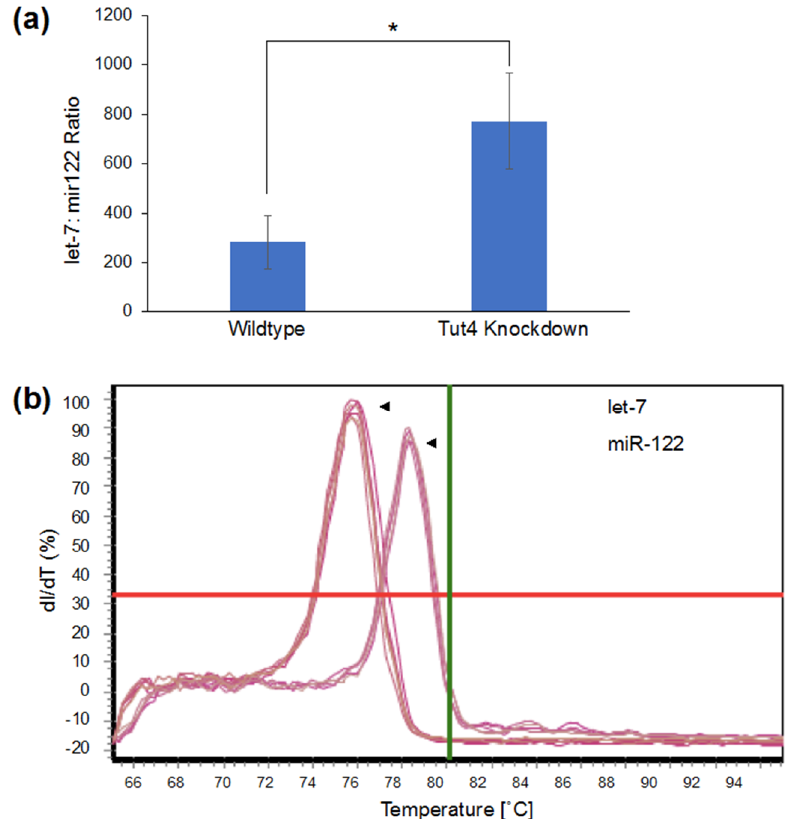
Figure 4. qPCR for let-7 miRNA in wildtype and Tut4-knockdown HEK293 cells. Cells were grown to confluence and total RNA was extracted. ( a ) Let-7 levels were quantified in relation to miRNA miR-122. miRNA levels in the wildtype and Tut4 knockdown are significantly different ( p < 0.03). Error bars are based on three biological replicates and show one standard deviation. ( b ) Melting curves of let-7 and miR-122 primers are distinct and specific. p values are * < 0.05.